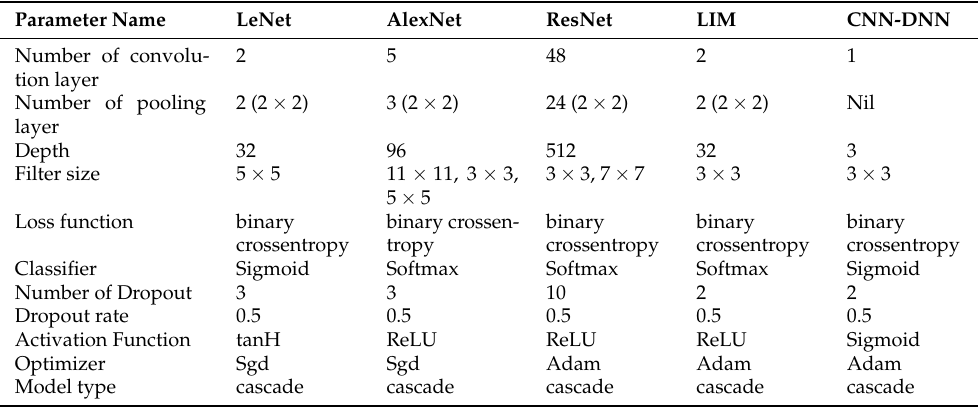
Table 2. Parameter differences and number of layers used in proposed method, LeNet, AlexNet and